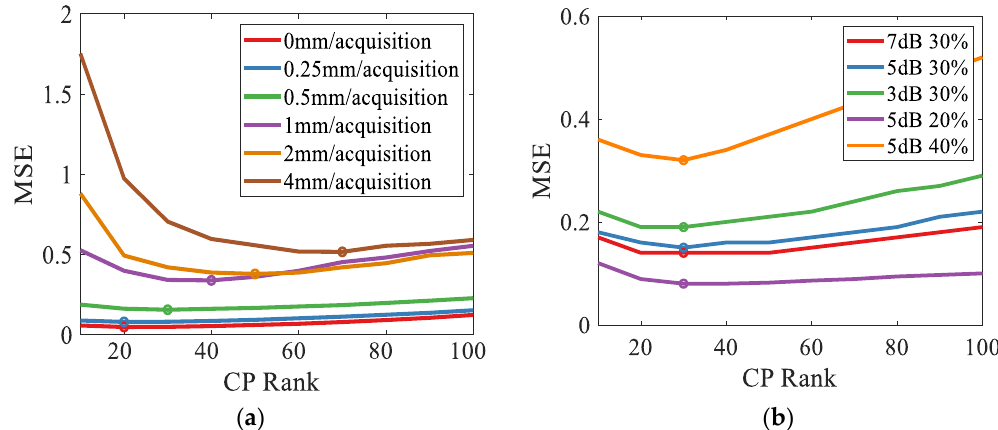
Figure 8. MSE between the low rank tensor acquired by CP decomposition and the noisy tensor with different CP ranks. ( a ) InSAR tensors with different deformation rates. ( b ) InSAR tensors with different noise conditions.